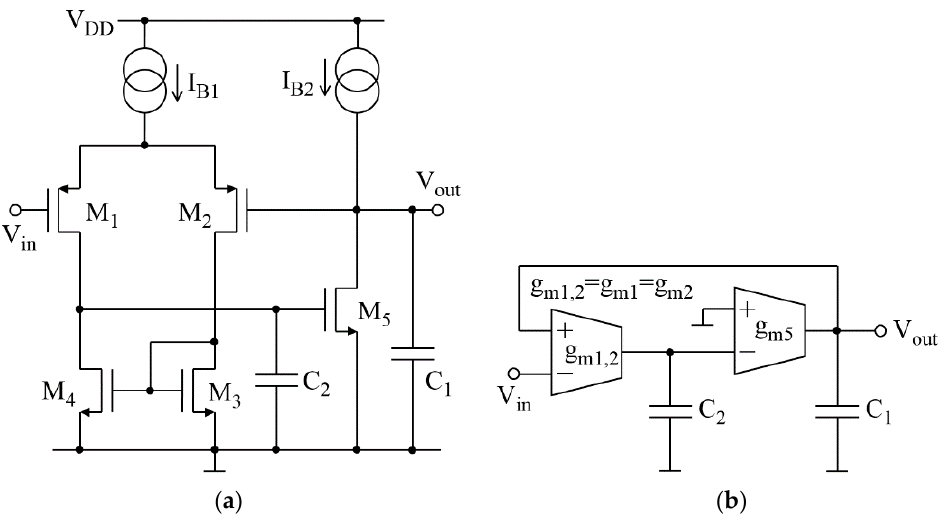
Figure 2. Example of a unity-gain buffer which cannot realize a second-order filter: ( a ) transistor-level circuit; ( b ) OTA-C (Gm-C) equivalent circuit.